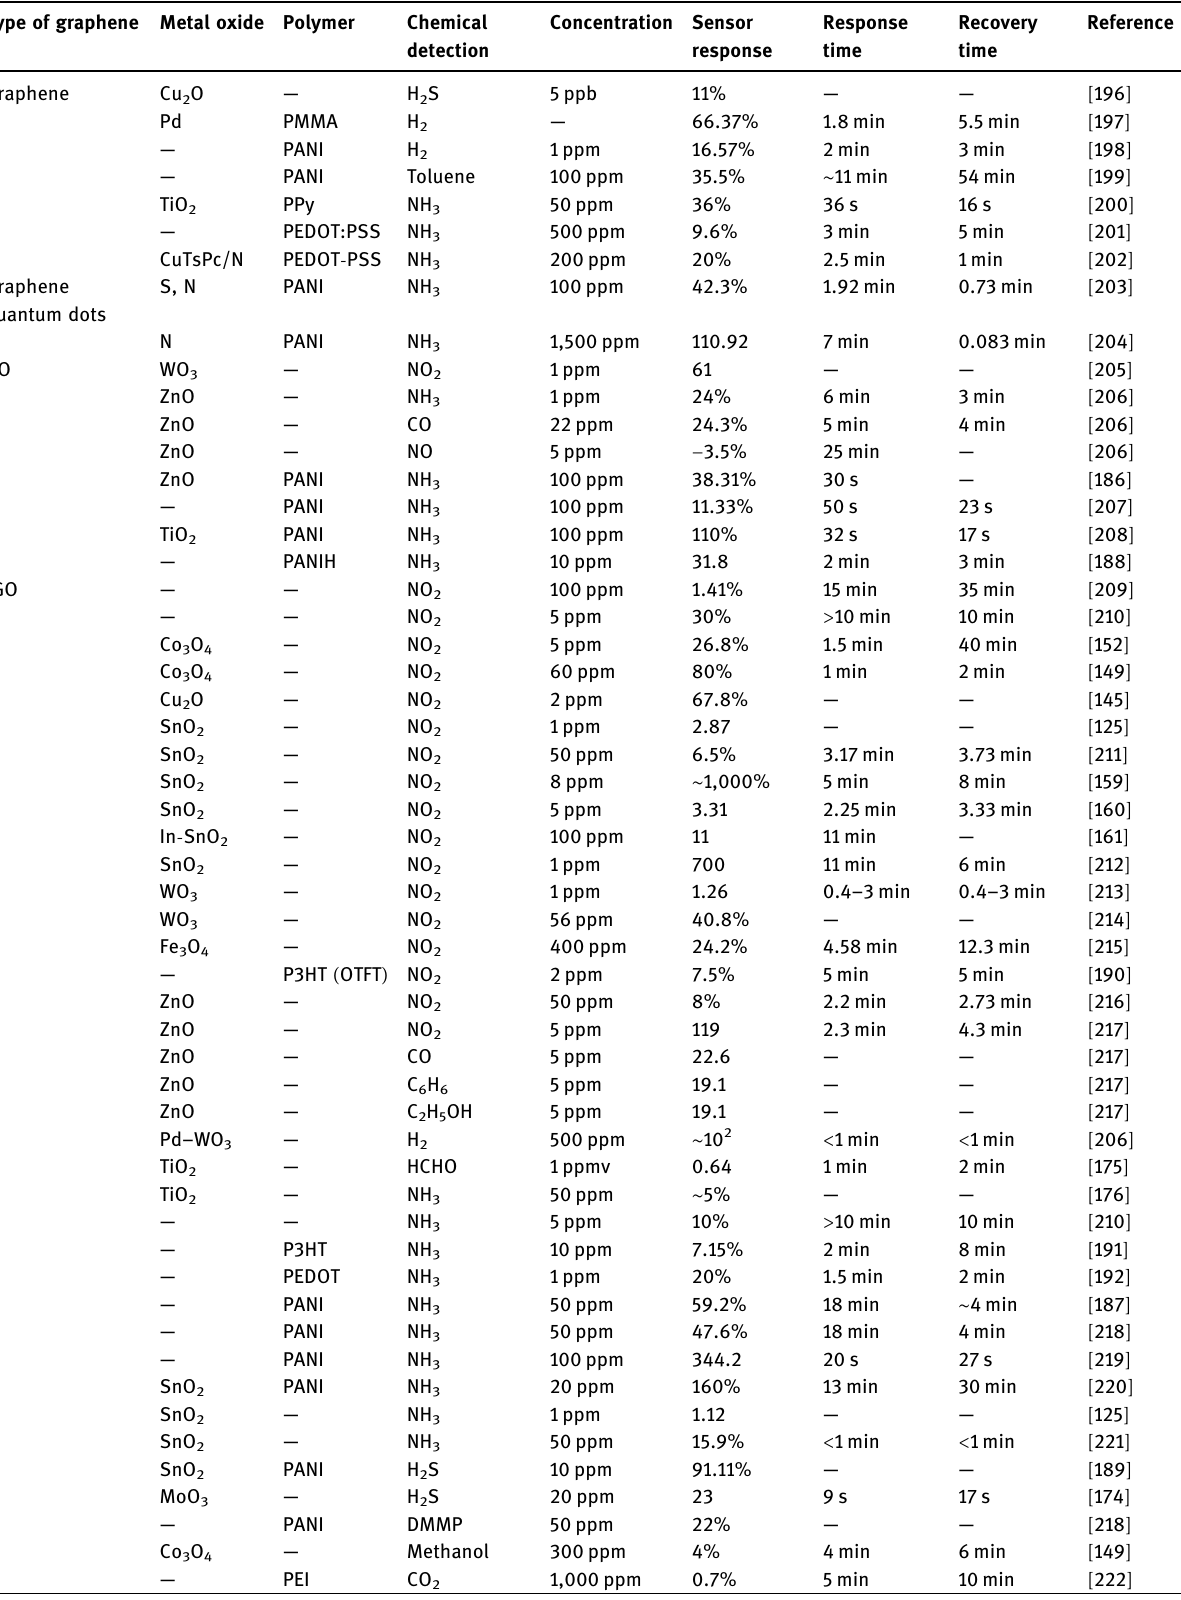
Table 4: Summary of hybrid and non - hybrid graphene - based chemical sensor performance Type of graphene Metal oxide